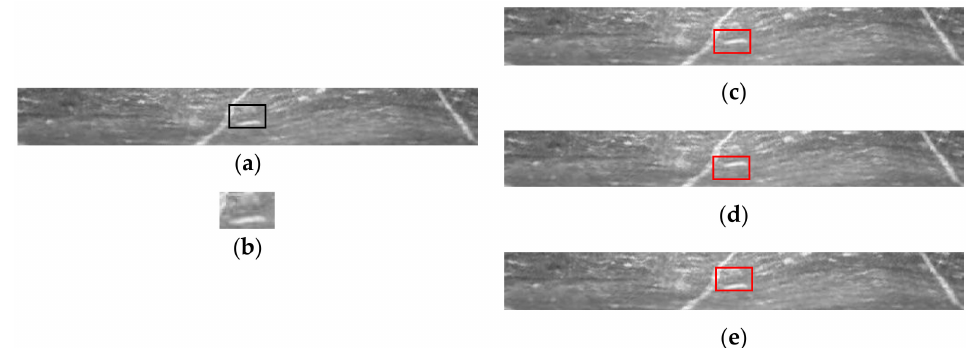
Figure 21. The matching result of two consecutive frames. ( a ) Source image; ( b ) template; ( c ) matching result of normalized cross correlation (NCC); ( d ) matching result of SAD and ( e ) matching result of the proposed PTSAD